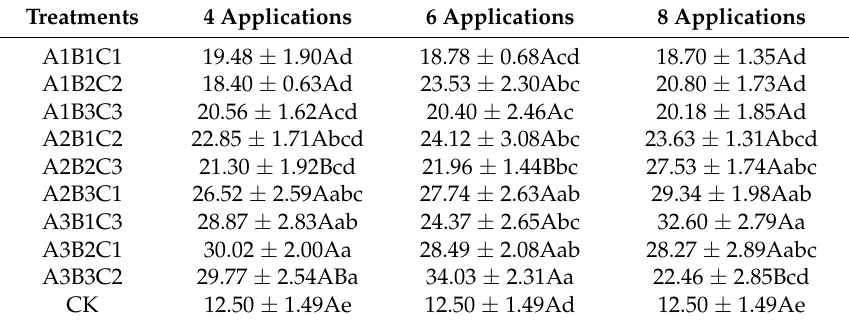
Table 10. Effects of different fertilization ratios and frequencies on whole plant biomass. Treatments 4 Applications 6